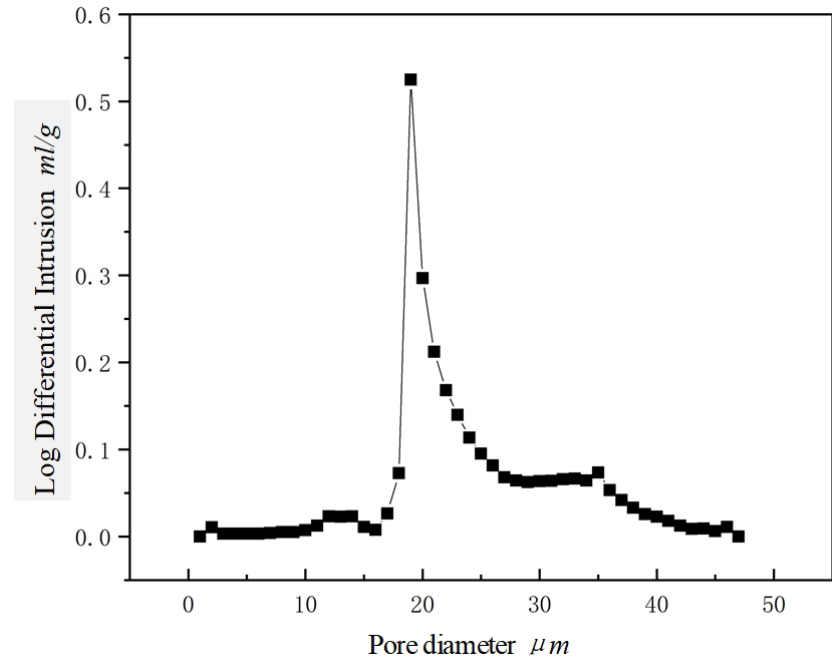
Figure 7. Pore diameter distribution of samples (Mercury penetration experiment).